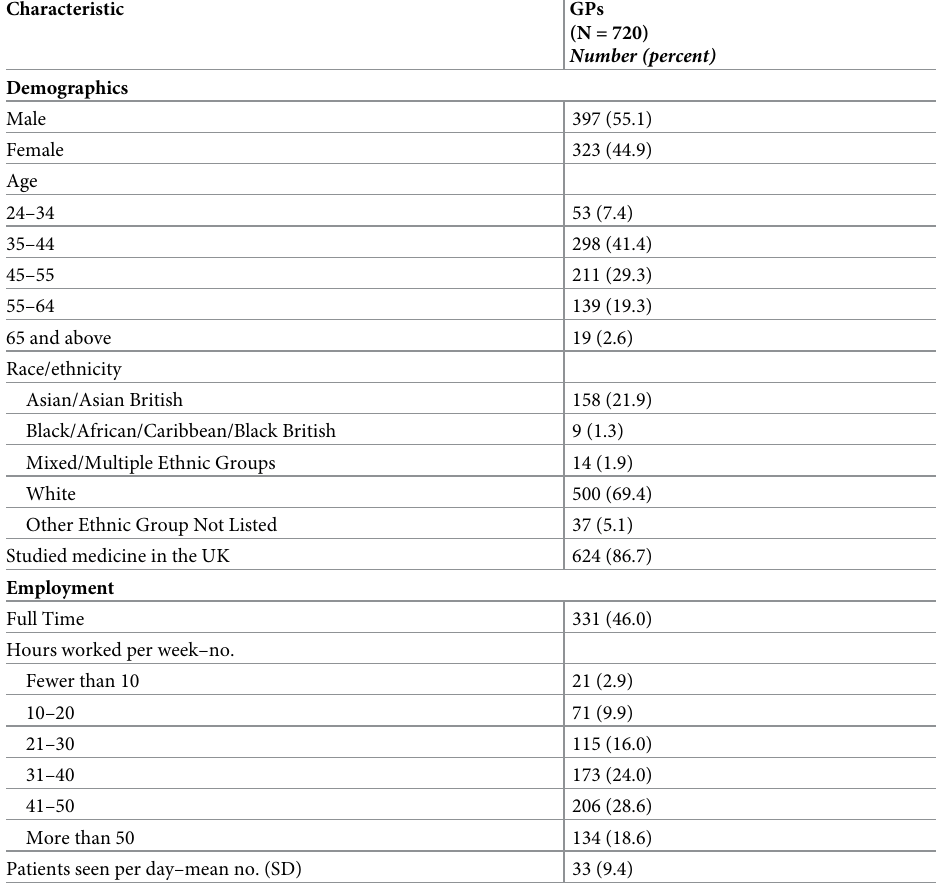
Table 1. Characteristics of the respondents and their practices �